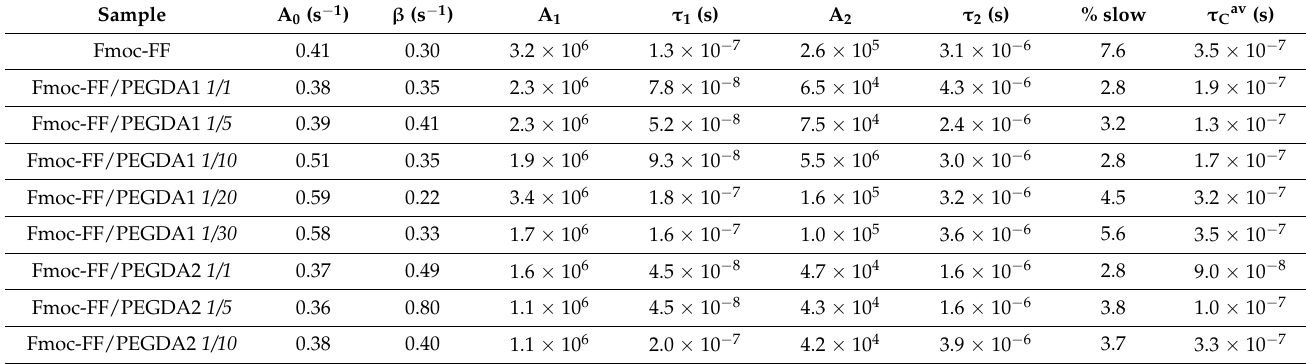
Table 2. Parameters obtained through fitting of the 1 H-NMRD